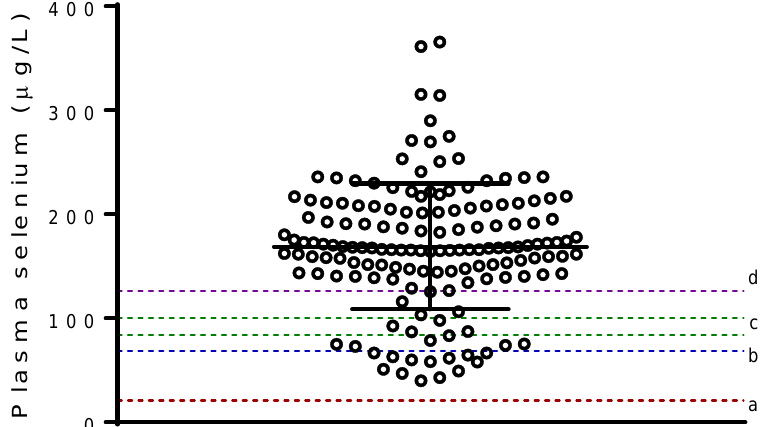
Figure 1. Plasma selenium concentration. Horizontal line corresponds to mean, and error bars to standard deviation. Dashed lines correspond to selenium concentration necessary for: (a) prevention of Keshan disease (>21 µg L -1 ), (b) optimal activity of iodothyronine 5′ deiodinases (IDIs) (>69 µg L -1 ), (c) maximization of plasma GPx activity (84–100 µg L -1 ), (d) protection against some cancers (>126 µg L -1 ).